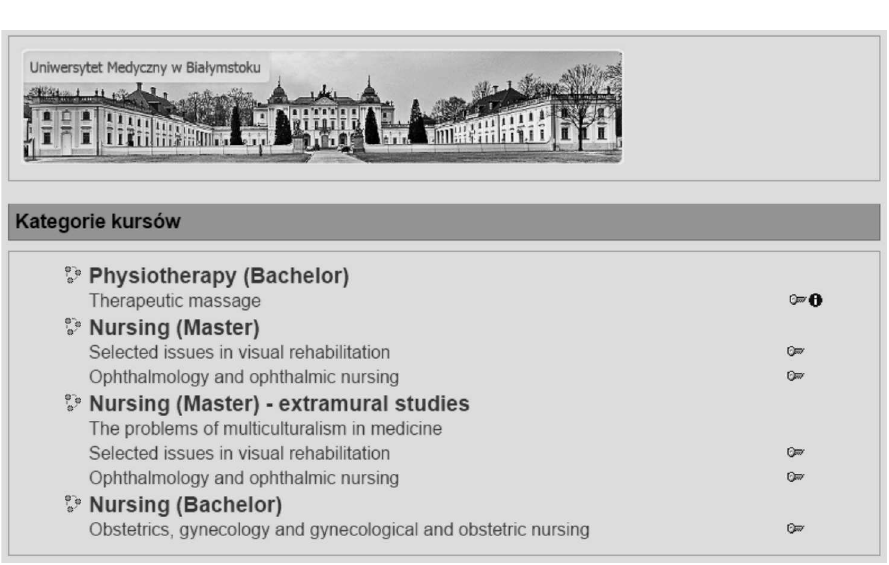
Figure 1. Main window of e-learning platform for the Medical University of